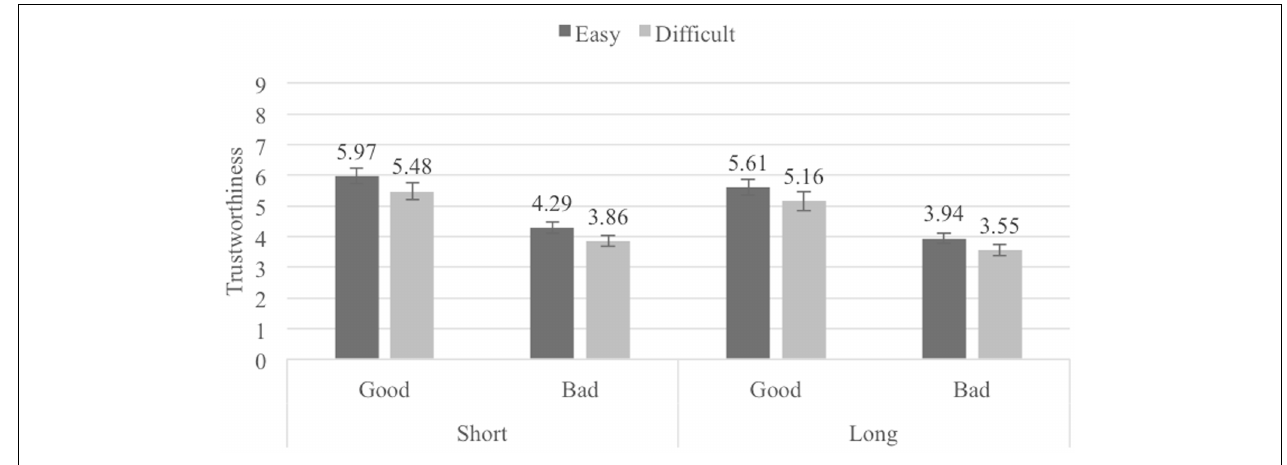
FIGURE 3 | Average trustworthiness ratings in Experiment 3, by Pronounceability, Length and Reputation conditions; error bars denote standard